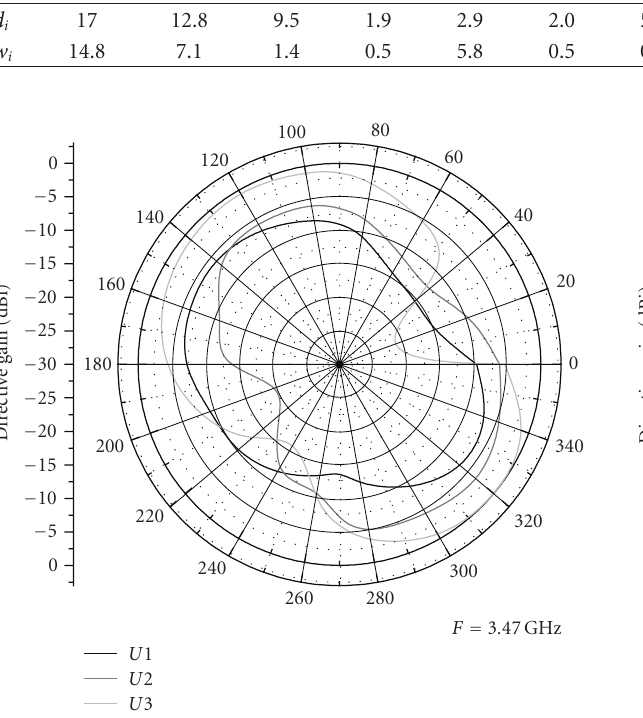
Figure 14: Directive gain for GPS at 1.57 GHz.